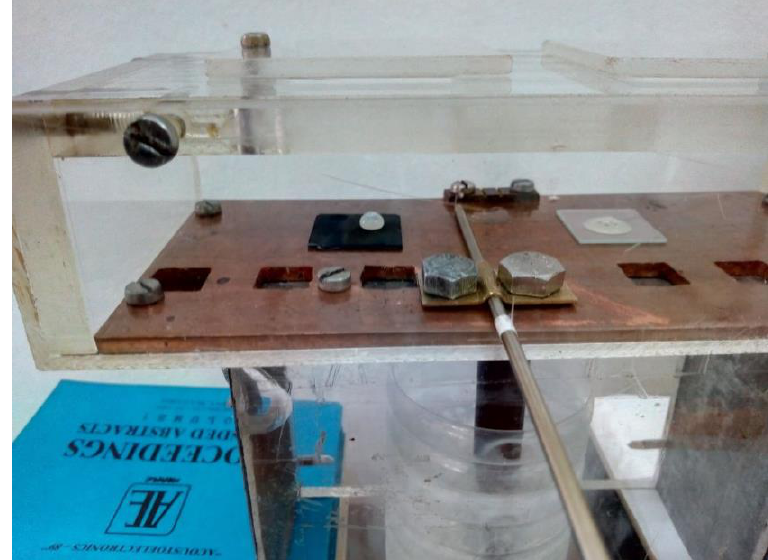
Figure 7. Cryoconservation of a seminal fluid through icephobic carbon soot coatings.